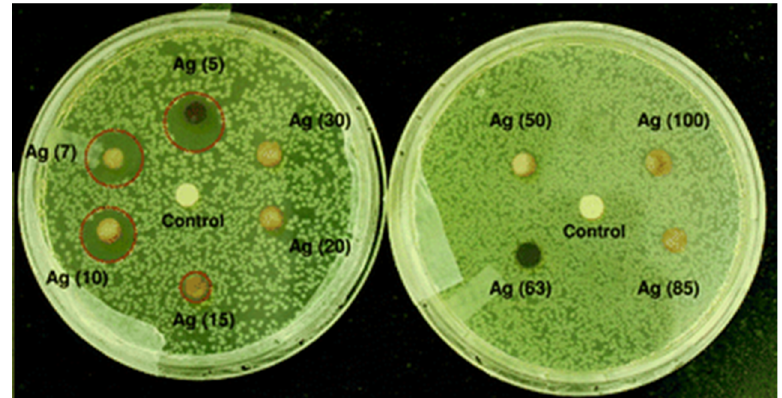
Figure 8. Disk diffusion assay results for AgNPs of various sizes against E. coli . The zone of inhibition is highlighted with a dashed circle indicating a noticeable antibacterial effect. Reproduced from [41], the Royal Society of Chemistry.